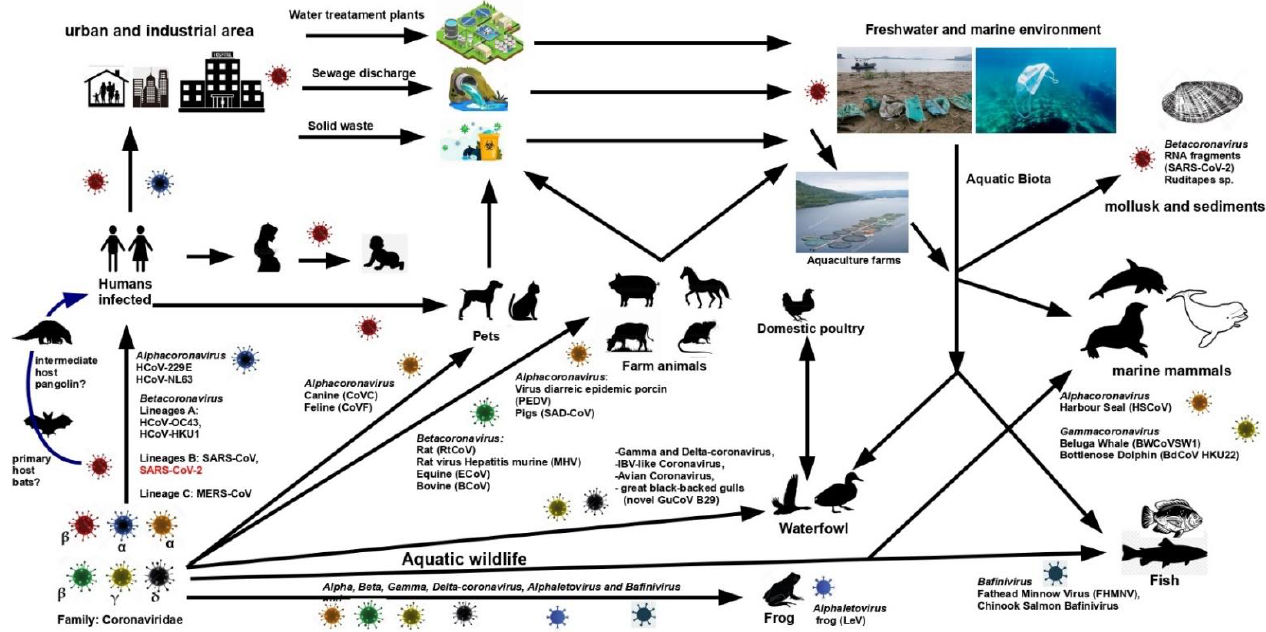
Figure 1. Main coronavirus groups and routes of direct or indirect transfer towards aquatic environments and aquatic biota.